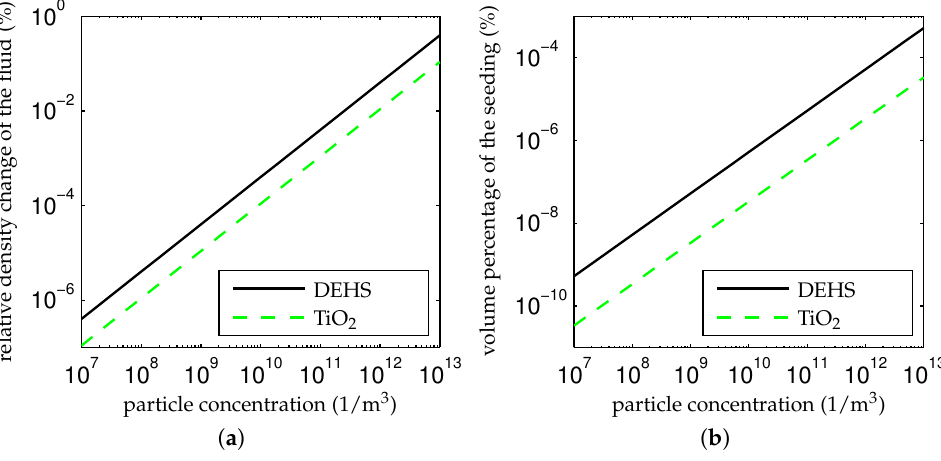
Figure 6. ( a ) Change of the mean density of the fluid due to the seeding and ( b ) volume percentage of the seeding over the particle concentration. the seeding over the particle